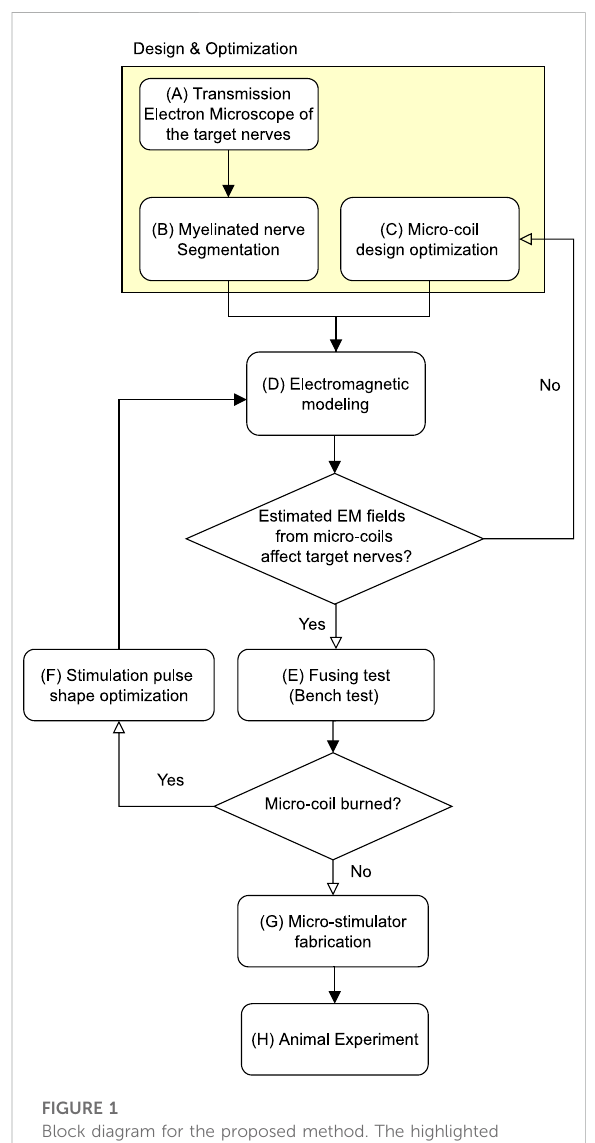
FIGURE 1 Block diagram for the proposed method. The highlighted region indicates the design and optimization